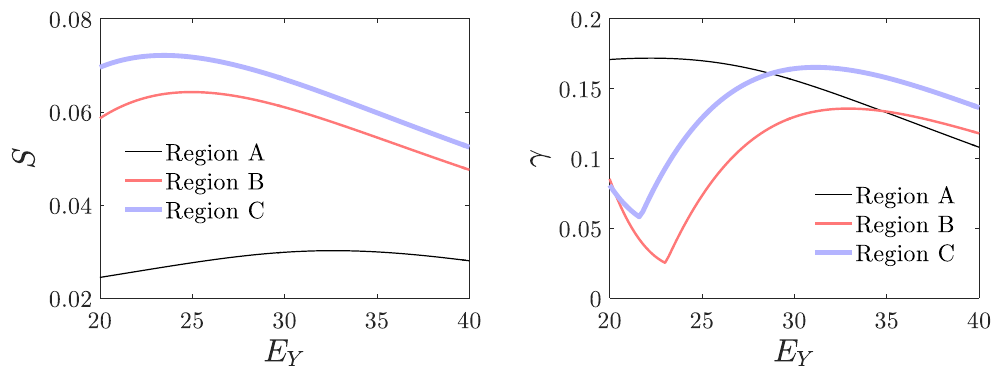
Figure 15. Influences of the detecting voltage on mechanical sensitivity and nonlinearity; Region A: E X = 10, Region B: E X = 25, and Region C: E X =